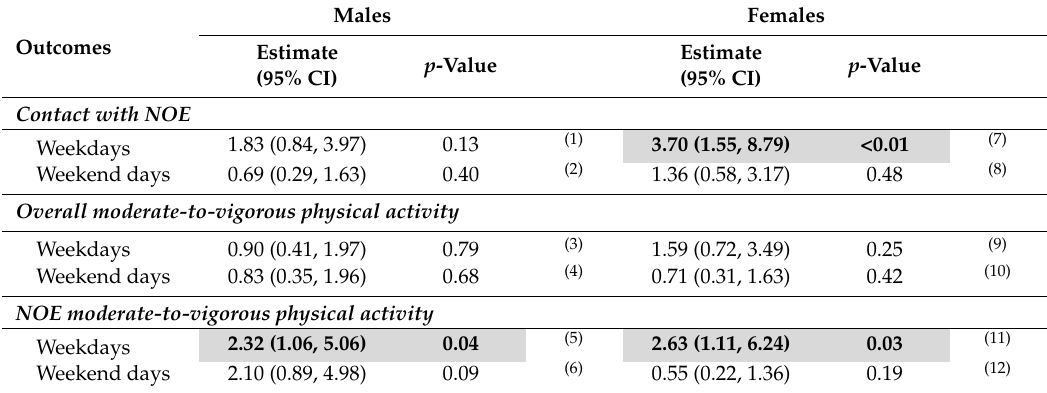
Table 5. Adjusted models for residential NOE availability at 300 m network buffer, stratified by gender.